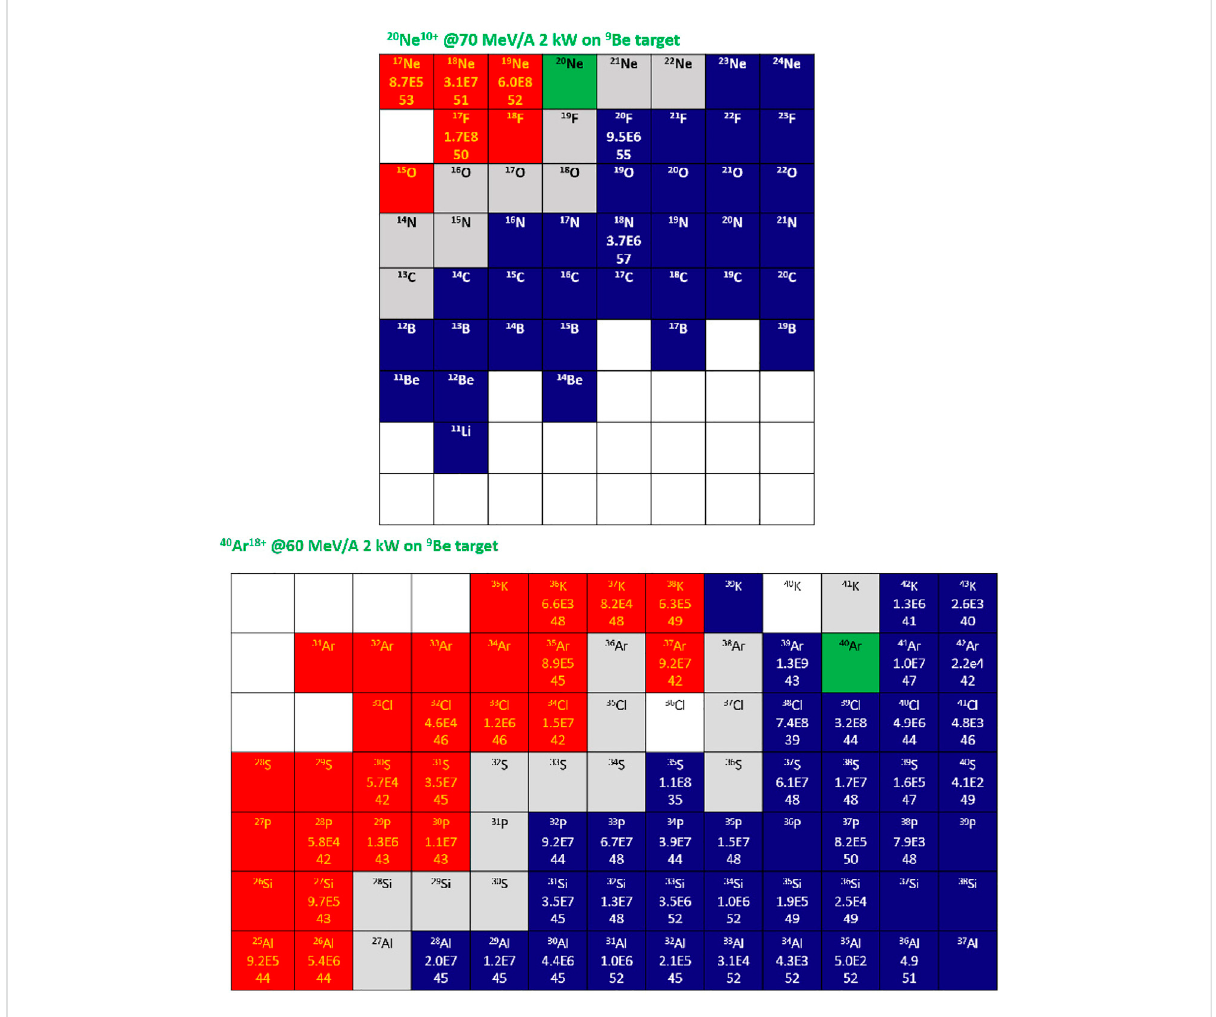
FIGURE 9 Top: simulation of RIBs achievable with FRAISE, using 20 Ne as the primary beam. Bottom: simulation of RIBs achievable with FRAISE, using 40 Ar as the primary beam. The fi gure is taken from [34].